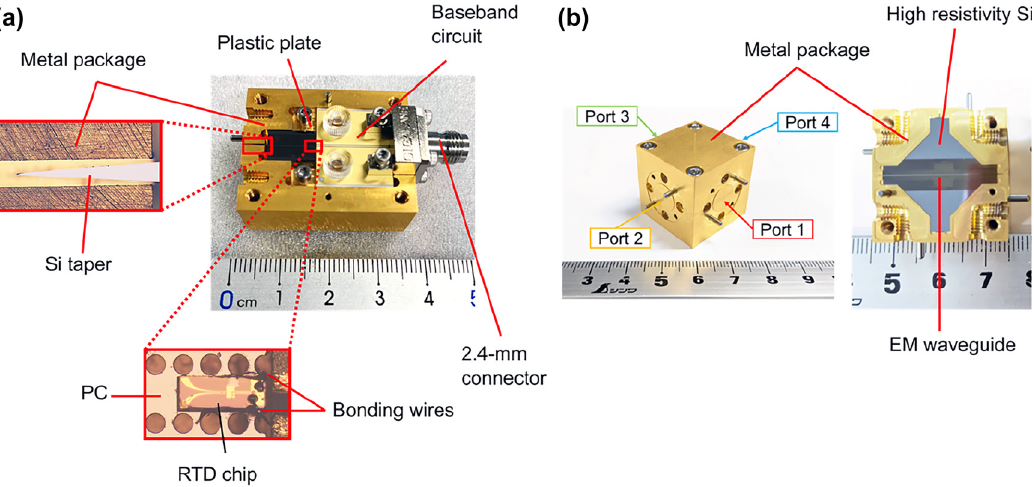
Figure 8: Packaged THz modules, (a) RTD integrated module with photonic crystal waveguide [28], (b) straight waveguide module [27].